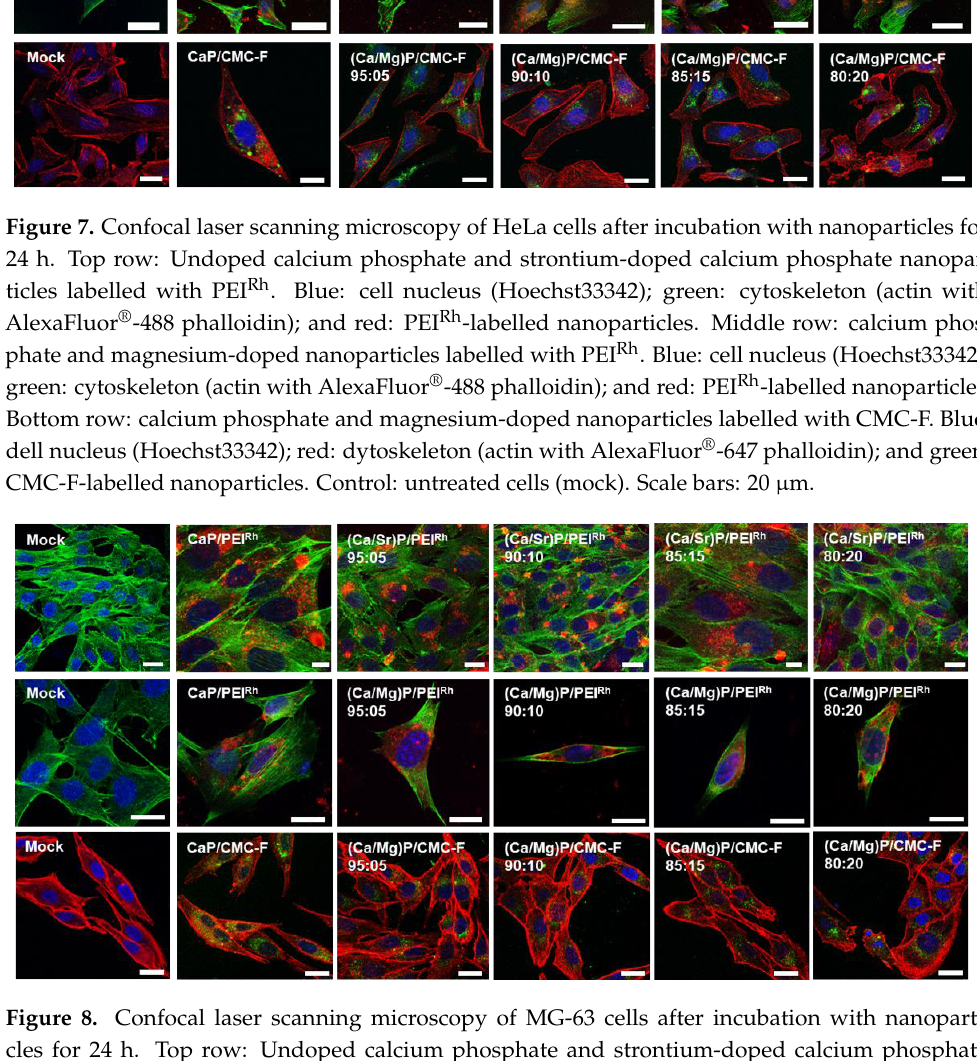
Figure 8. Confocal laser scanning microscopy of MG-63 cells after incubation with nanoparticles for 24 h. Top row: Undoped calcium phosphate and strontium-doped calcium phosphate nanoparticles labelled with PEI Rh . Blue: cell nucleus (Hoechst33342); green: cytoskeleton (actin with AlexaFluor ® -488 phalloidin); and red: PEI Rh -labelled nanoparticles. Middle row: Calcium phosphate and magnesium-doped nanoparticles labelled with PEI Rh . Blue: ell nucleus (Hoechst33342); green: Cytoskeleton (actin with AlexaFluor ® -488 phalloidin); and red: PEI Rh -labelled nanoparticles. Bottom row: Calcium phosphate and magnesium-doped nanoparticles labelled with CMC-F. Blue: Cell nucleus (Hoechst33342); red: Cytoskeleton (actin with AlexaFluor ® -647 phalloidin); and green: CMC-F-labelled nanoparticles. Control: untreated cells (mock). Scale bars: 20 µm.